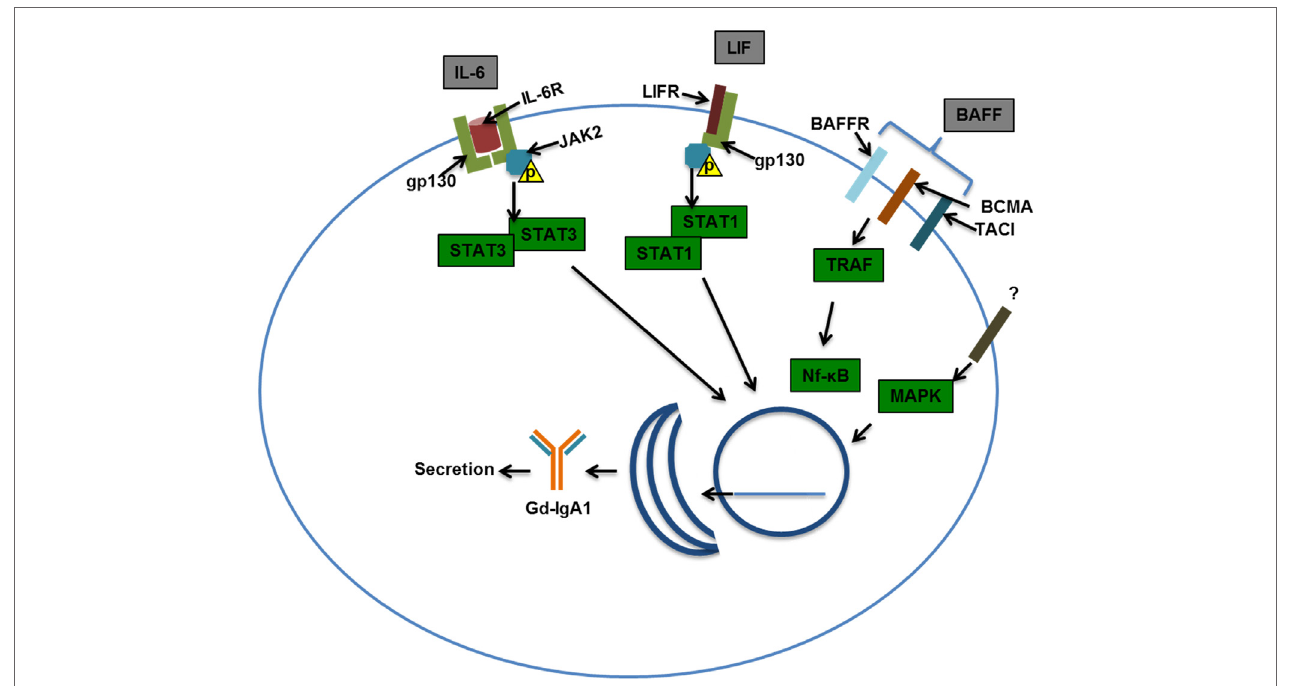
FiGURe 4 | examples of signaling pathways that may affect production of galactose-deficient igA1 . Interleukin-6 (IL-6) binds to the IL-6 receptor (IL-6R) and through co-receptor gp130 (glycoprotein 130) activates Janus kinase 2 (JAK2), which in turn phosphorylates signal transducer and activator transcription 3 (STAT3), leading to its dimerization and nuclear translocation. Leukemia inhibitory factor (LIF) binds gp130 and LIF receptor (LIFR) that also activates JAK2, leading to STAT1/3 activation and nuclear translocation. B-cell-activating factor (BAFF) can bind multiple receptors, BAFF receptor (BR), B-cell maturation antigen (BCMA), and transmembrane activator and calcium-modulating/cyclophilin ligand protein (TACI). Activation of TNF-receptor-associated factor (TRAF) by TACI, BAFFR, and BCMA leads to NF- k B activation and nuclear translocation. Mitogen-activated protein kinase (MAPK) activation has been shown to affect O -glycosylation and thus was included in this scheme. Nuclear translocation of the STATs and NF- k B may be important in driving production of Gd-IgA1 in IgA1-producing cells and/or maintaining viability/proliferation of these cells in patients with